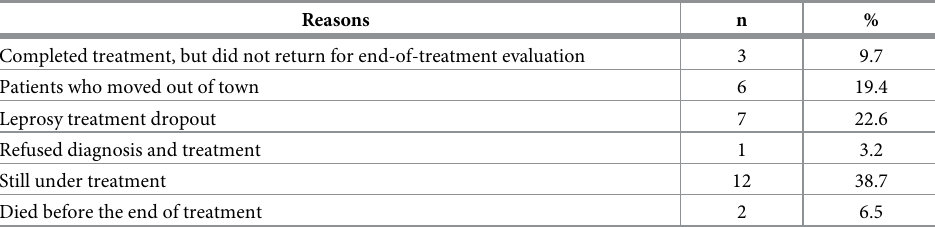
Table 3. Reasons for not performing SWM-test in 31